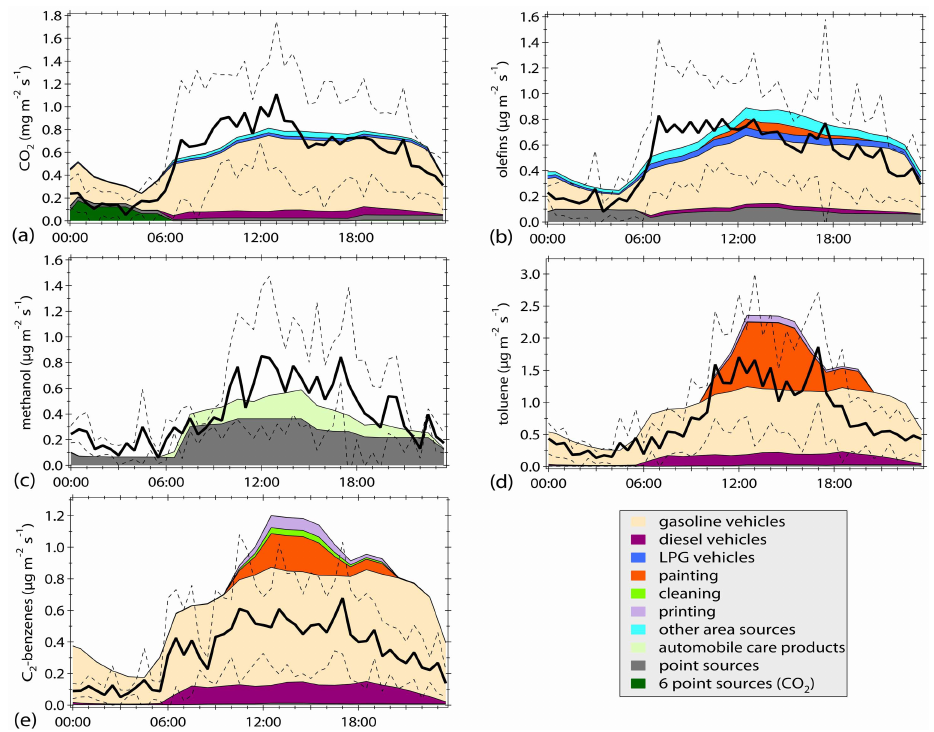
Fig. 9. Diurnal emission profiles distributed by source types for CO 2 (a) , olefins (b) , methanol (c) , toluene (d) , and C 2 -benzenes (e) . The emissions of CO 2 , olefins, toluene and C 2 -benzenes were extracted from the grid cells coinciding with the 6-h footprints obtained for different periods of the diurnal course, while the methanol emissions represent the 63 surrounding cells. The black lines correspond to the average fluxes measured during the entire field campaign, while the dashed lines indicate ± 1 standard deviation of the measured